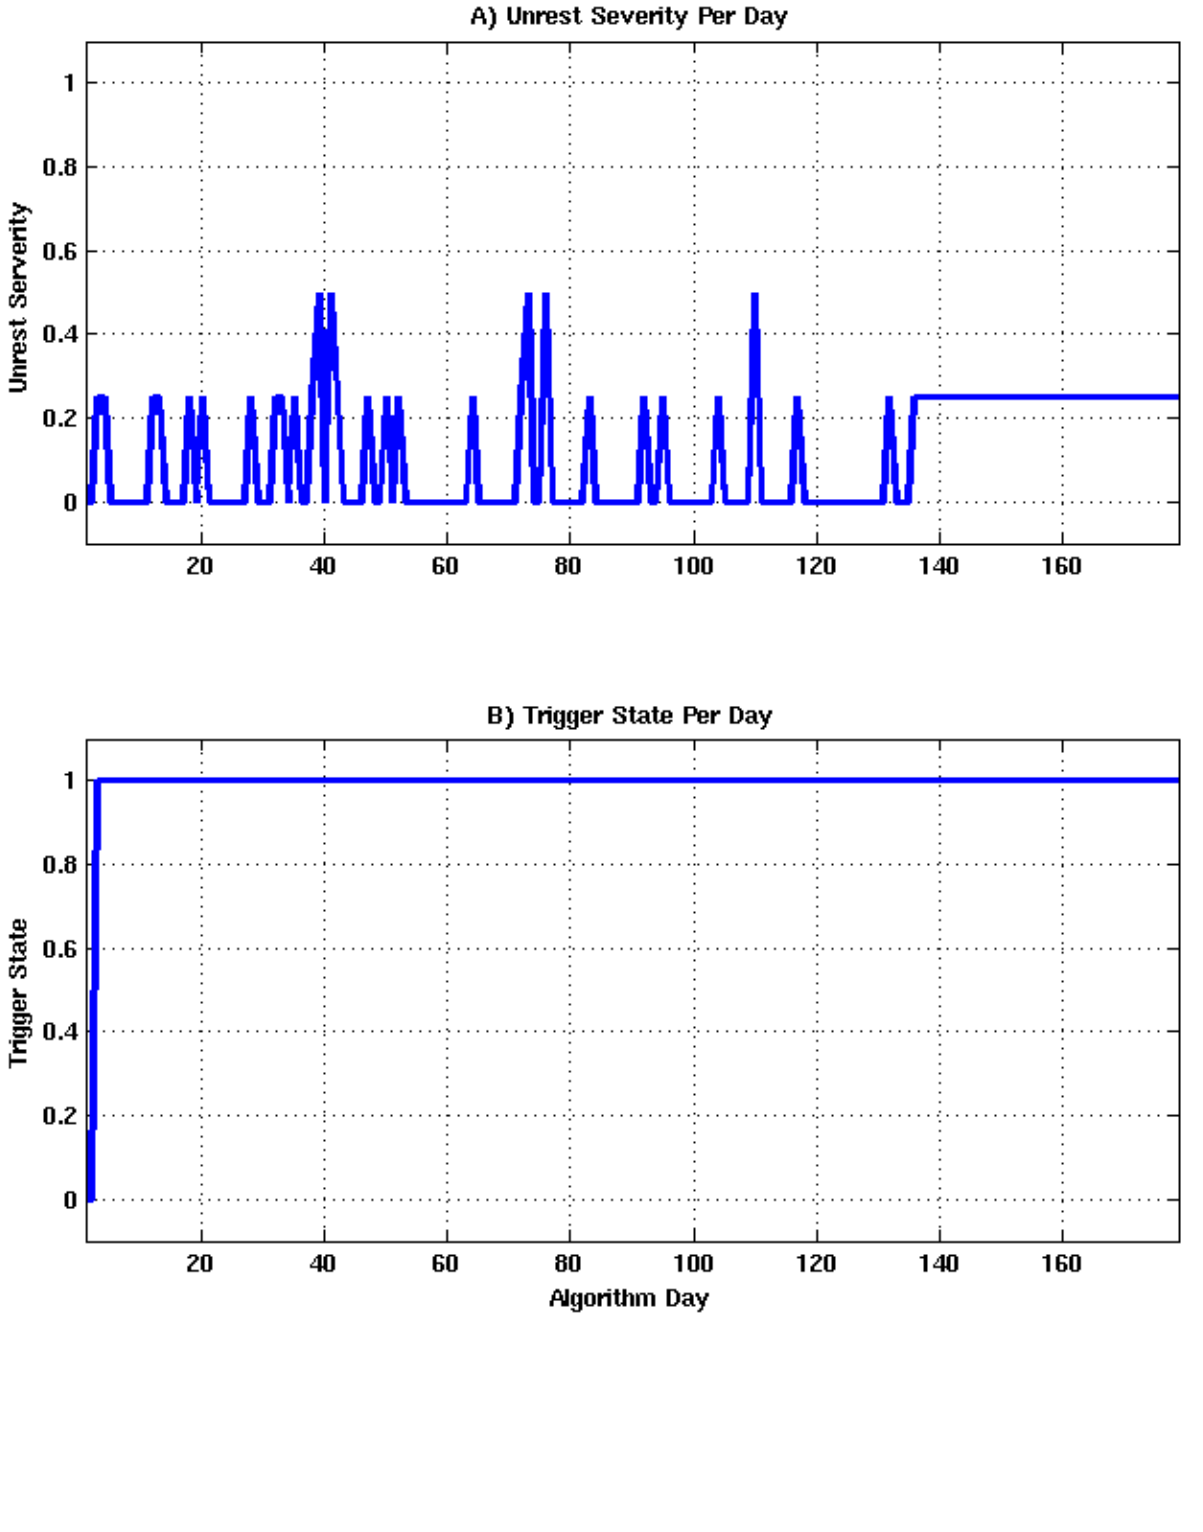
Figure 13. Algorithm state as a function of processing day. ( A ) Unrest severity estimates per day; ( B ) Trigger state per